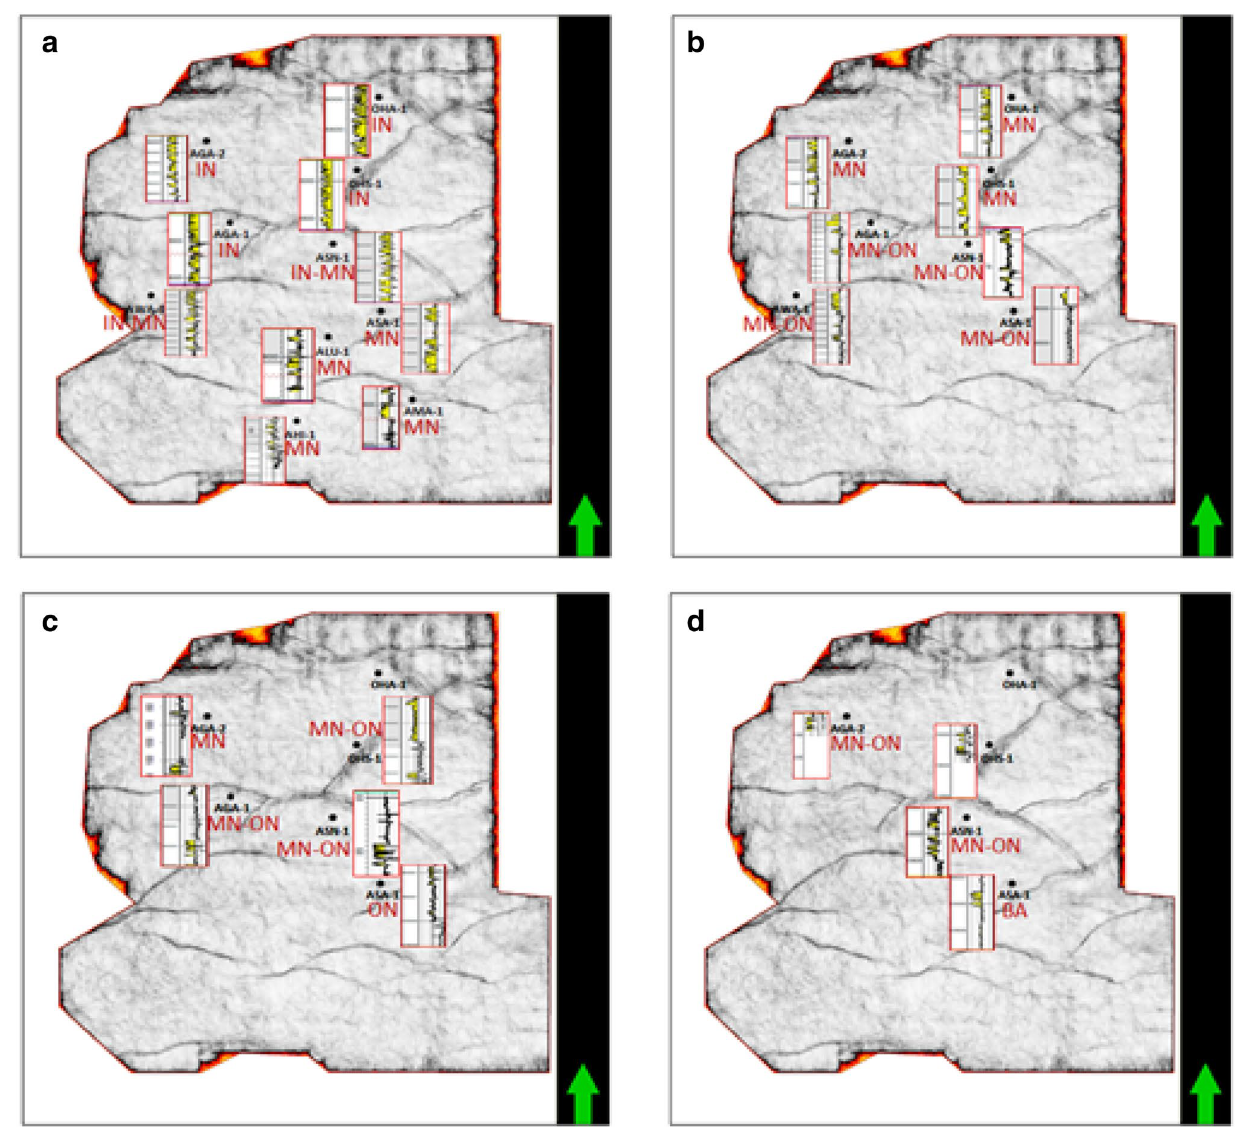
Fig. 8 Lithofacies using gamma ray log and paleobathymetric interpretation using IN inner neritic, MN middle neritic, ON outer neritic, BA bathyal, from a MFS 26.2 to 28.1, b MFS 28.1 to 31.3, c MFS 31.3 to 33.0 and d MFS 33.0 to